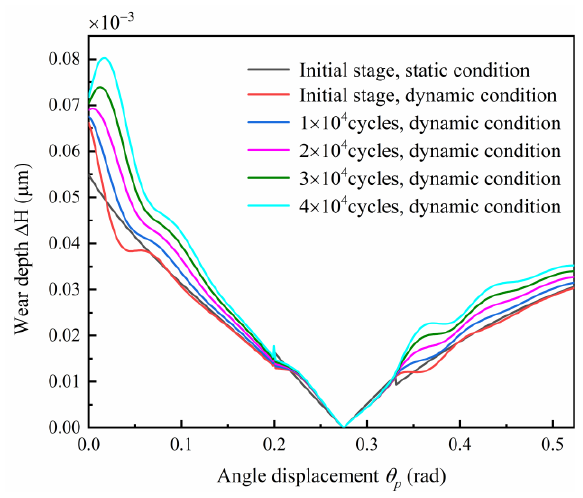
Figure 11. The meshing force and wear depth distribution of a pinion under static and dynamic conditions in the initial stage. (Dotted lines donate the static condition, and solid lines donate the dynamic condition).